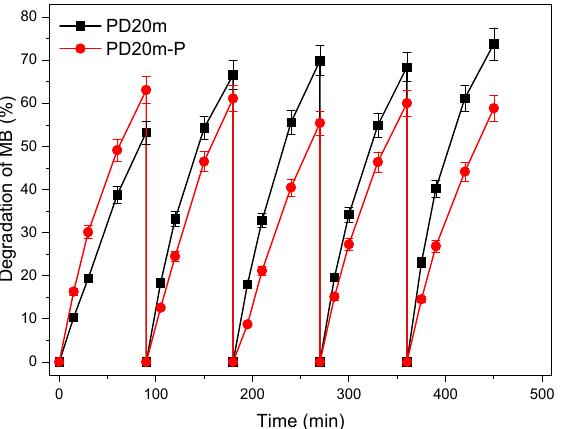
Figure 9. Photocatalytic performance of the PD20m and PD20m-P coatings in the MB degradation experiment, measured over five cycles.